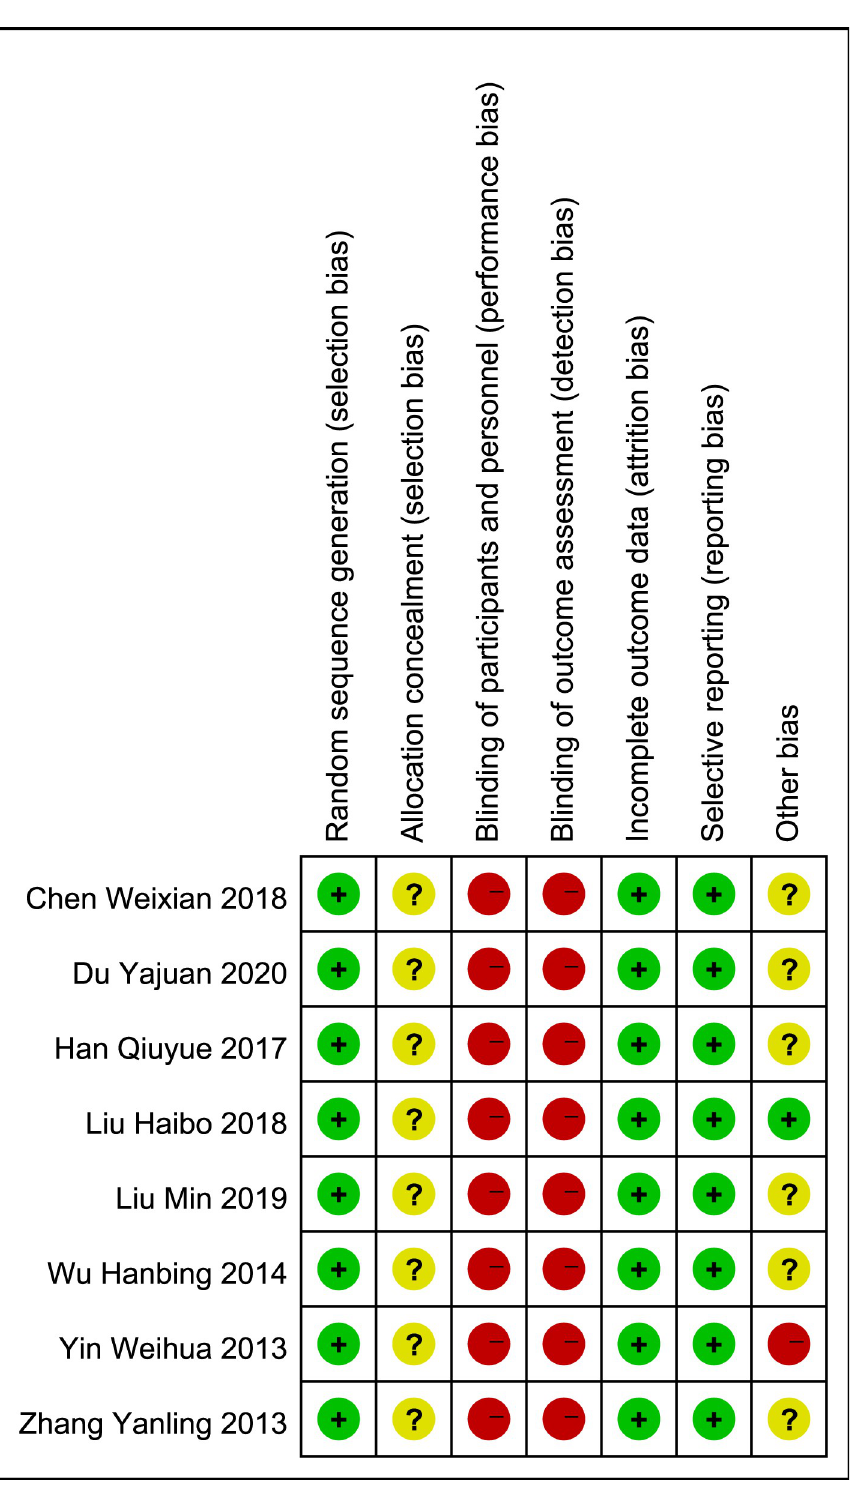
Fig 3. Summary chart of quality